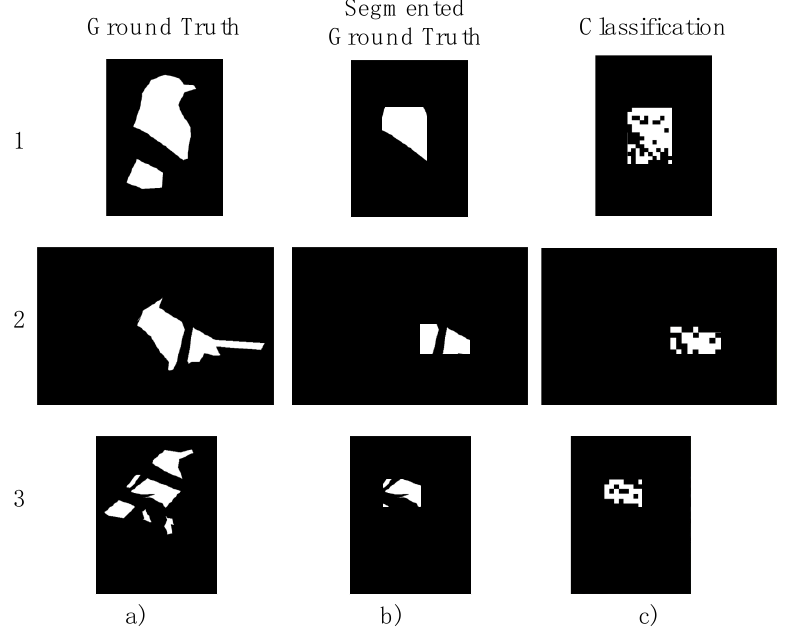
Figure 13. Comparative methodology results for three large images with occlusion. ( a ) original segmented image, ( b ) segmented image by proposed segmentation, ( c ) 15 × 15-pixel window classification.